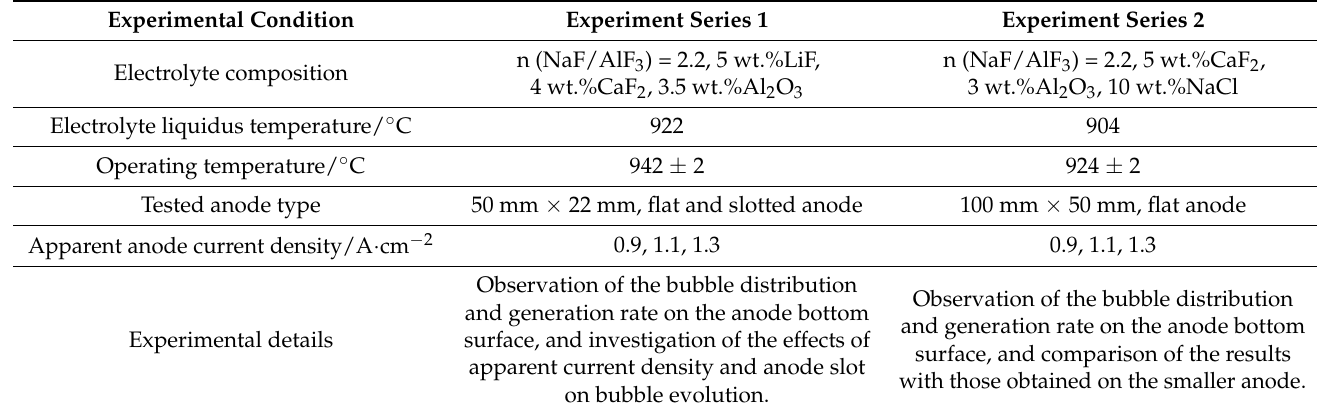
Table 1. Experimental